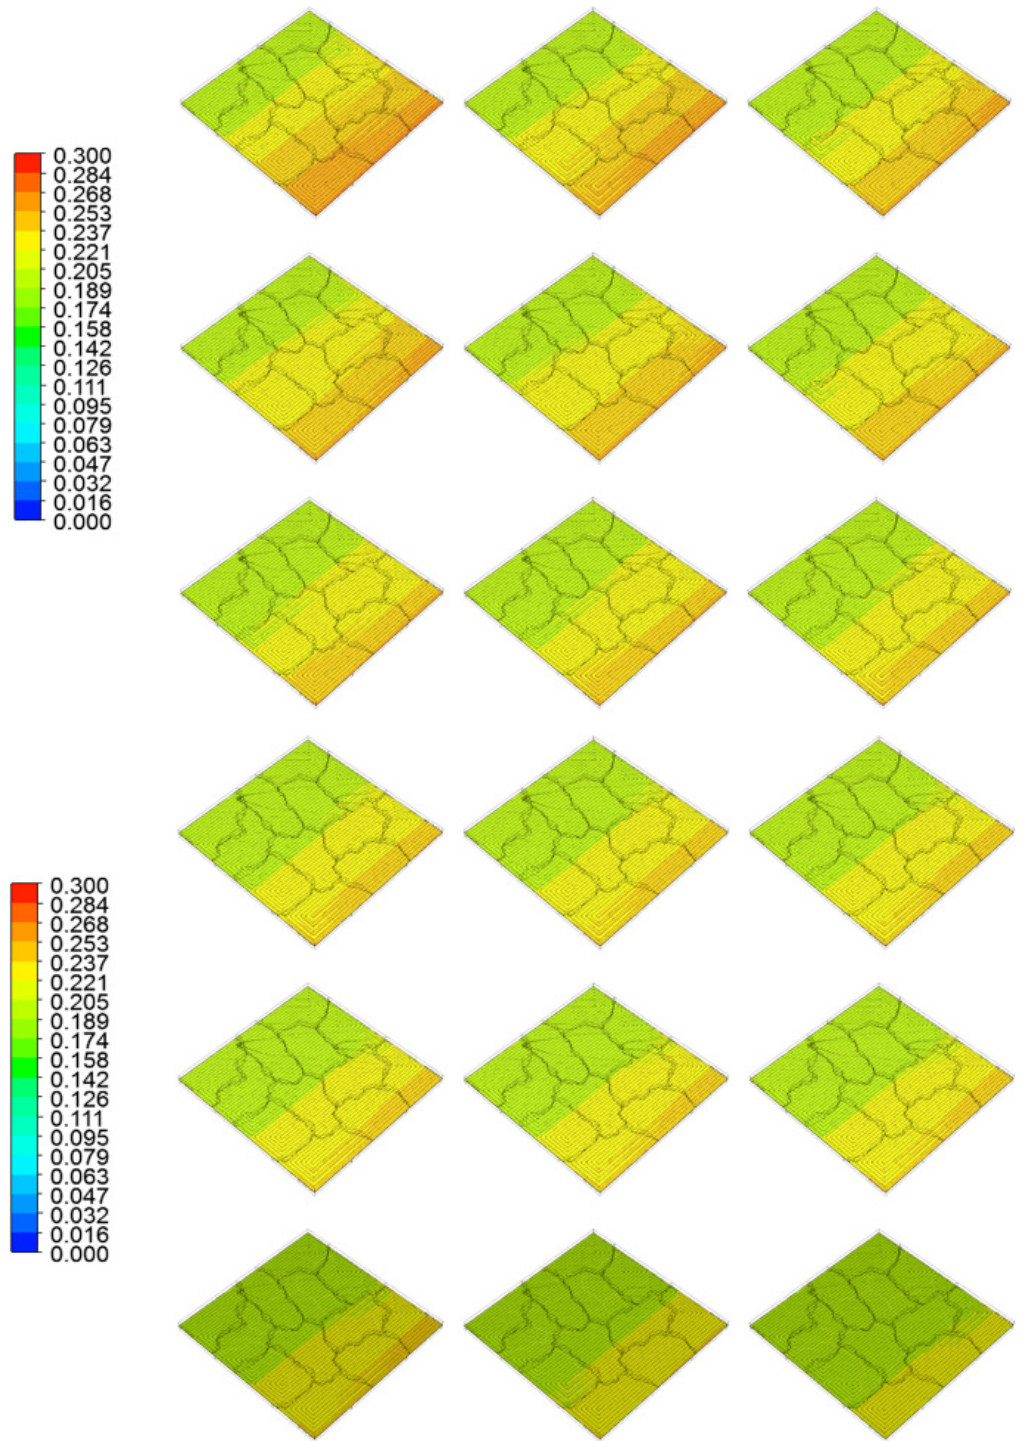
Figure 9. Anode catalyst layer hydrogen mass fraction history every 1 s, from 10 ( top left ) to 27 s ( bottom right ). Anode inlet left corner, anode outlet right corner.